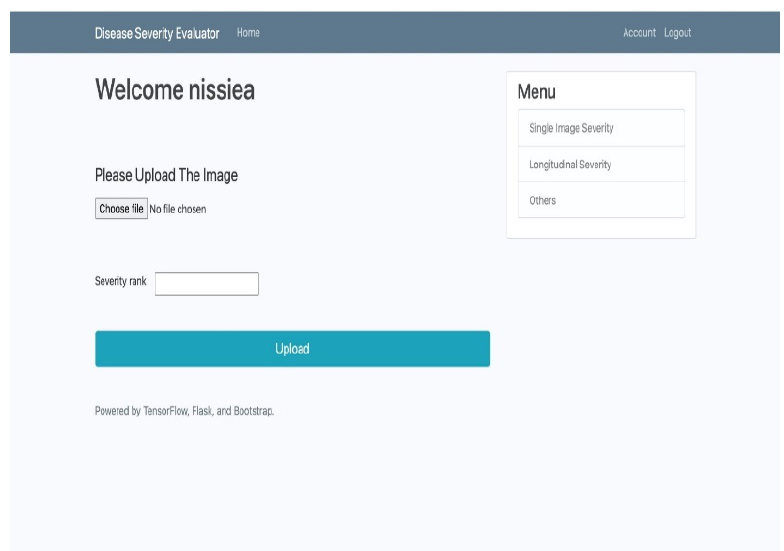
Figure 7: Web evaluator home page